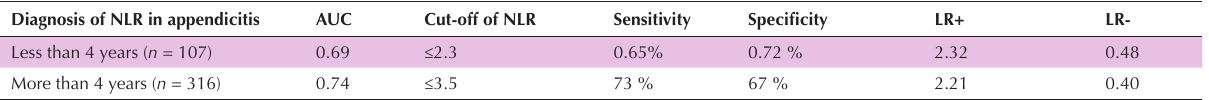
Table 3. Diagnostic value of neutrophil to lymphocyte ratio in younger and older pediatrics suspect to acute appendicitis Diagnosis of NLR in